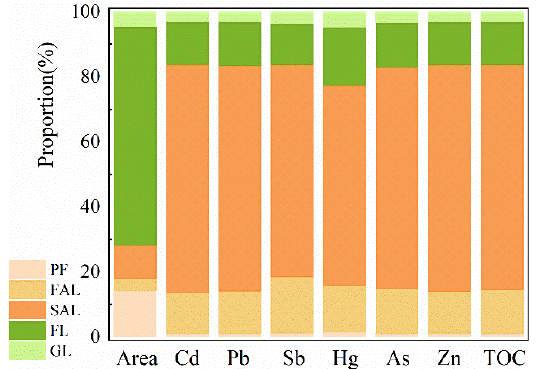
Figure 4. The proportions of annual PTE loss in different land types (PF: paddy field, FAL: dry arable land (slope ≤ 6°): SAL: dry arable land (slope > 6°), FL: forest land, GL: grassland). land (slope ≤ 6 ◦ ): SAL: dry arable land (slope > 6 ◦ ), FL: forest land, GL: